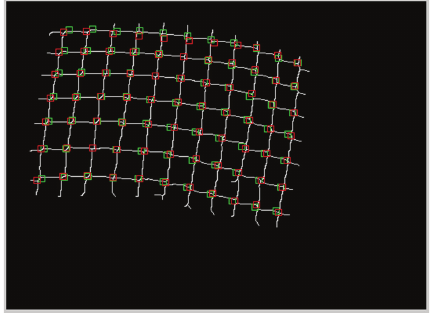
Figure 10: The matched points from both